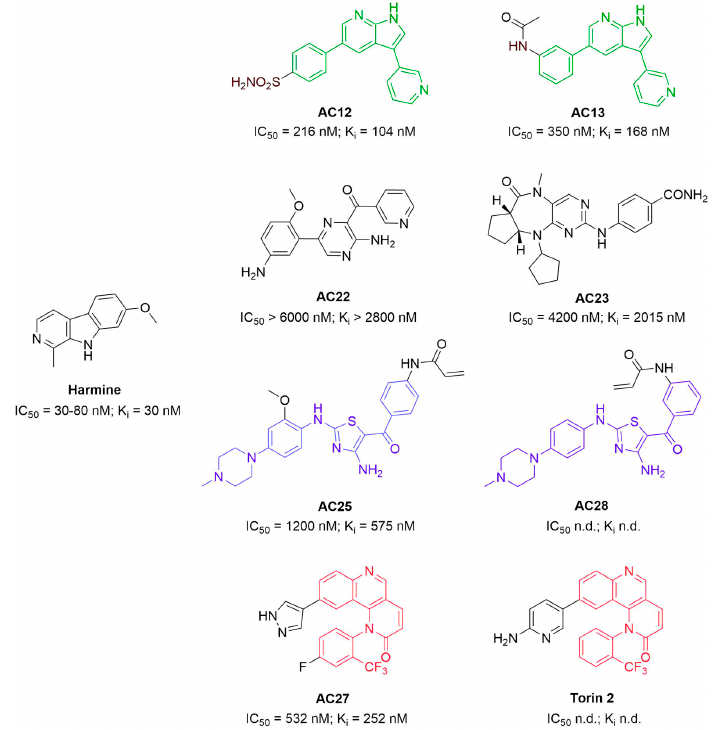
Figure 1. Chemical structures of the investigated DYRK1A inhibitors. IC50 and Ki values are referenced in Czarna et al. [44]. Here, we report DYRK1A inhibitors evaluation at the cellular, ex vivo, and human organoid level. The compounds potently promote human β -cell proliferation and enhance insulin secretion. Characterization of the involved pathways supports the on-target effects of tested compounds. The effects are more pronounced than the current gold standard harmine, providing significant improvement to the available toolset of small molecules with β -cell regenerating potential. 2. Materials and Methods 2.1. Materials All DYRK1A inhibitors: 4-(3-(pyridin-3-yl)-1H-pyrrolo[2,3-b]pyridin-5-yl)benzenesulfonamide (AC12); 4-(3- pyridin-3-yl-1H)-pyrrolo[2,3-b]pyridin-5-yl)acetanilide (AC13); (3-azanyl-6-(5-azanyl-2- methoxy-phenyl)pyrazin-2-yl)-pyridin-3-yl-methanone (AC22); 4-(((6aS,9aR)-10-cyclo- pentyl-5-methyl-6-oxo-5,6,6a,7,8,9,9a,10-octahydrocyclopenta[e]pyrimido[5,4-b][1,4]di- azepin-2-yl)amino)benzamide (AC23); N -(4-((4-azanyl-2-((2-methoxy-4-(4-methylpiper- azin-1-yl)phenyl)amino)-1,3-thiazol-5-yl)carbonyl)phenyl)propenamide (AC25); 1-(4- fluoro-2-(trifluoromethyl)phenyl)-9-(1H-pyrazol-4-yl)benzo[h][1,6]naphthyridin-2-one (AC27); N -(3-((4-azanyl-2-(4-(4-methylpiperazin-1-yl)phenyl)amino)-1,3-thiazol-5-yl)car- bonyl)phenyl)propenamide (AC28); were kindly provided by Prof. Nathanael Gray